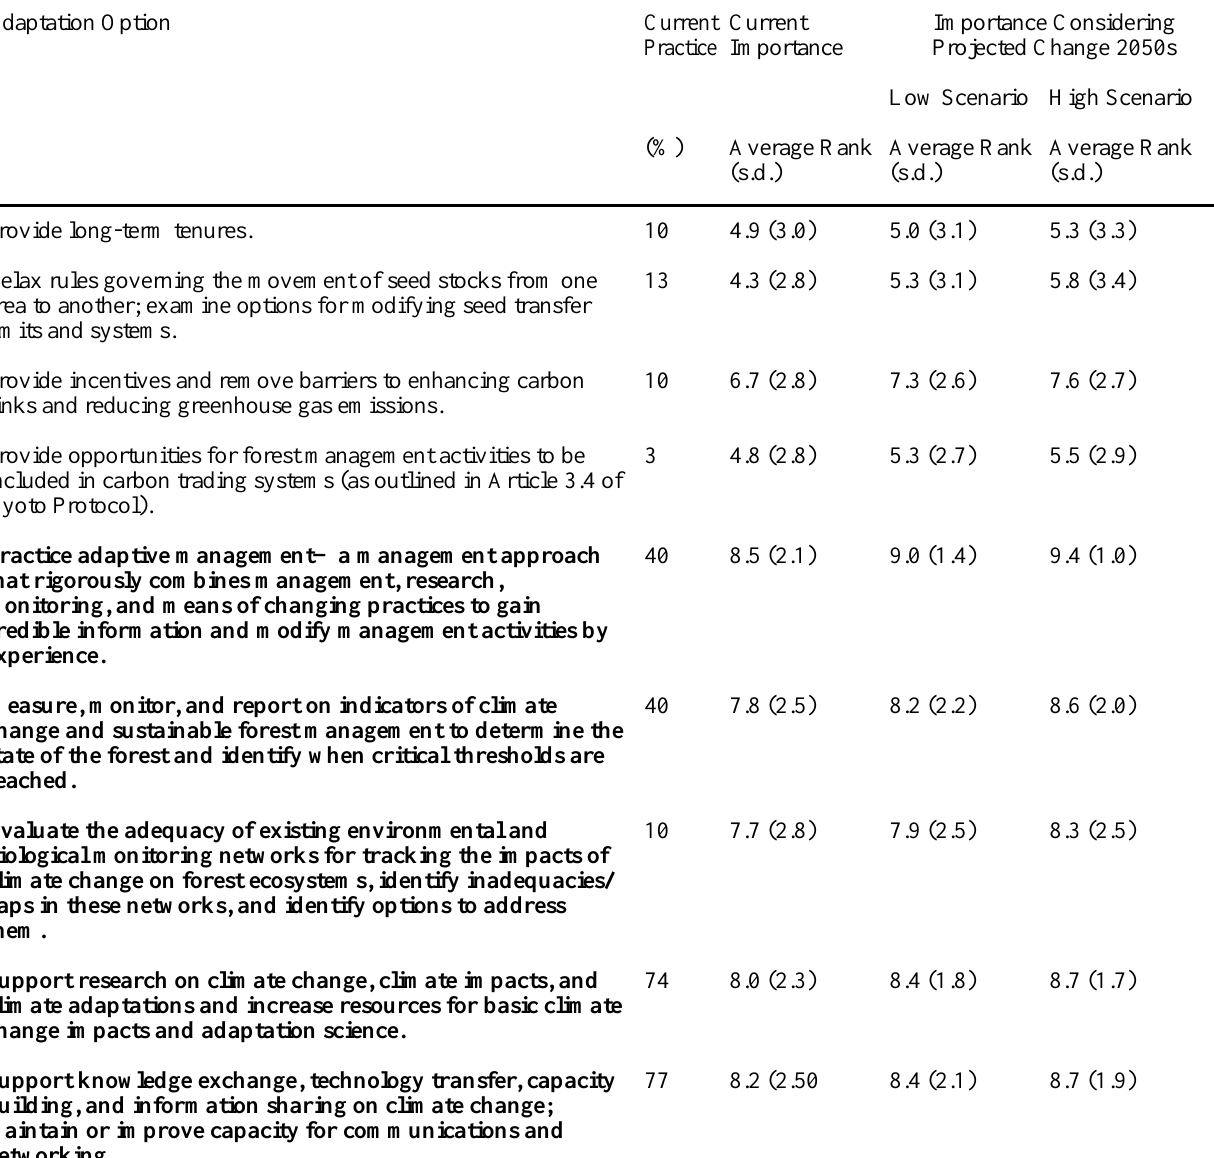
Table 10. Judgments of forest practitioners on the importance of options to adapt the present legal, institutional, and economic framework for forest conservation and sustainable management for each of three scenarios: “current climate conditions,” “low scenario of future climate change by the 2050s,” and “high scenario of future climate change by the 2050s.“ Scale of 1 to 10 (0 = no importance, 1 = low importance, 10 = high importance) or don’t know. Results shown are the average rank and standard deviation (s.d.) of participants who provided a ranking. The percentage of participants who agree or strongly agree with the statement “this management option is currently being practiced in the Yukon” is also